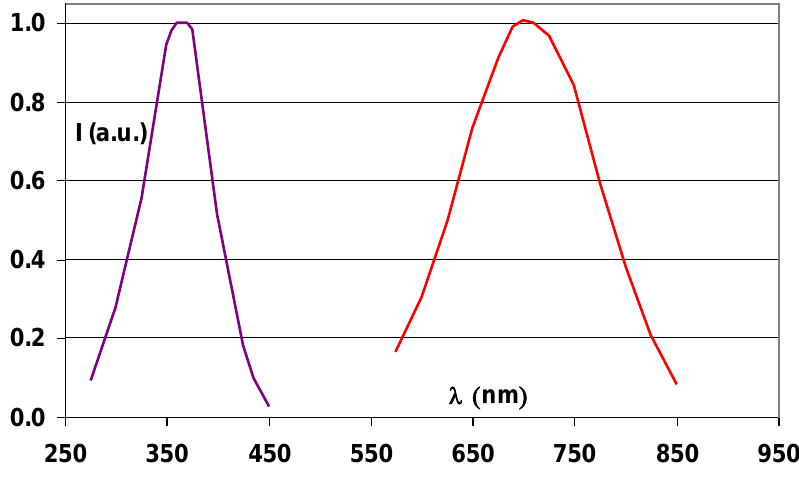
Figure 21. Emission (violet) and stimulation (red) spectrum of RbBr:Tl + storage phosphor (data from [67]).